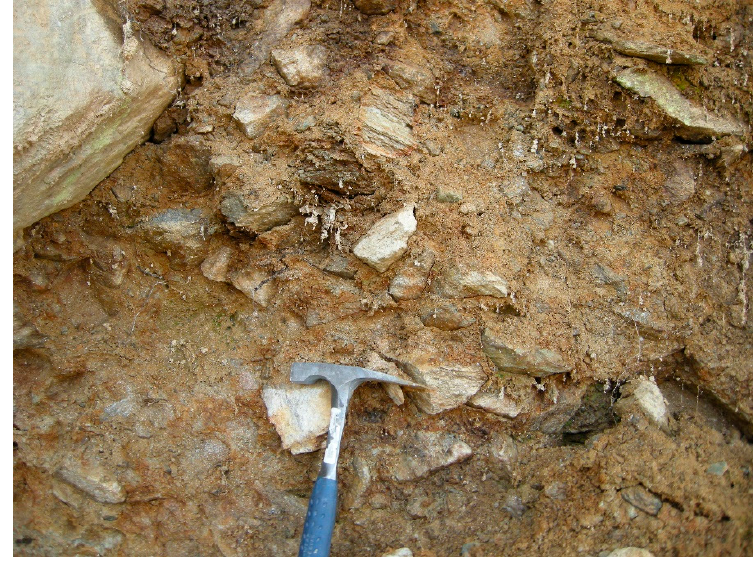
Figure 8. Typical features of glacial marginal sediments outcropping in sector 3, characterized by medium permeability for